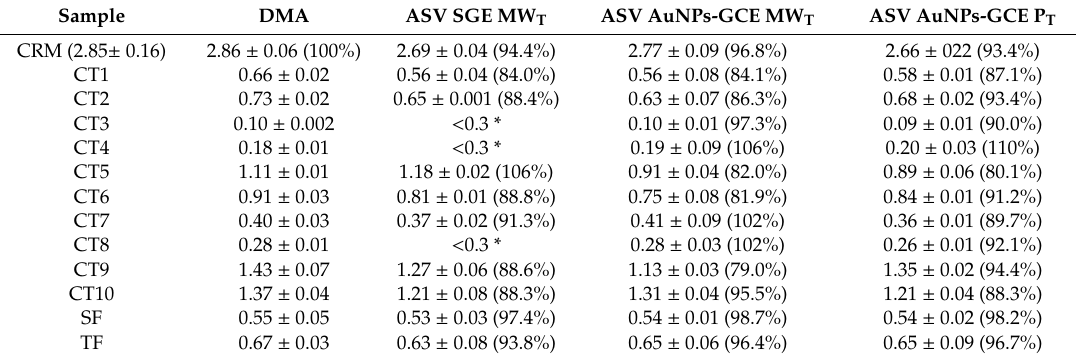
Table 2. Mercury concentrations (mg kg − 1 of fresh weight) and recoveries (%) obtained by DMA and ASV using SGE (with MW T ) and AuNPs-GCE (with MW T and P T ). Supporting electrolyte: 0.06 M NaCl